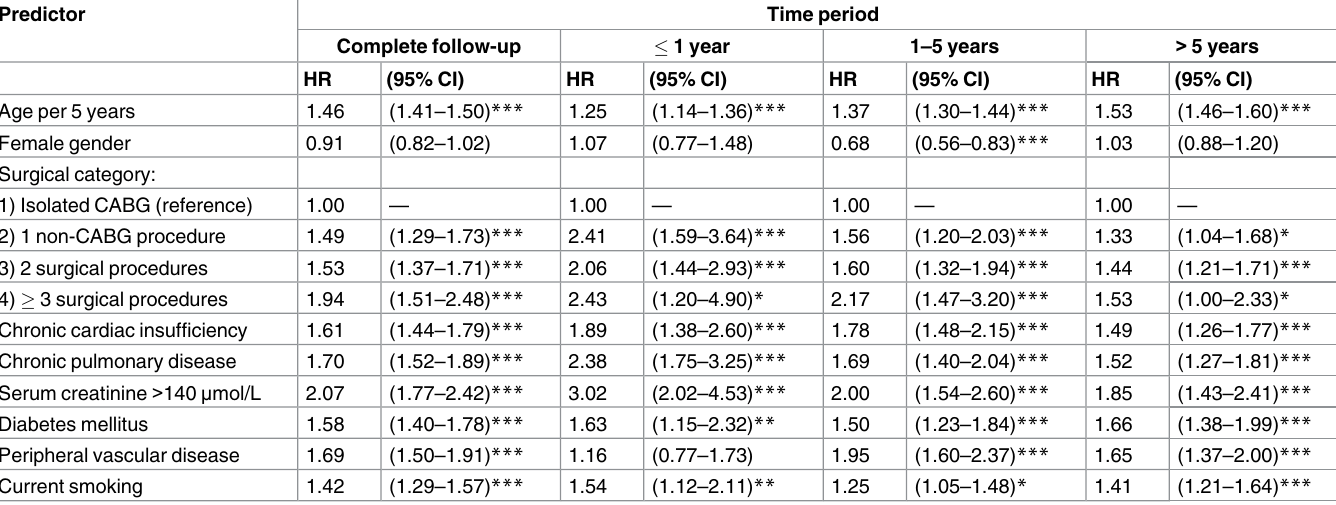
Table 2. Risk factors associated with observed